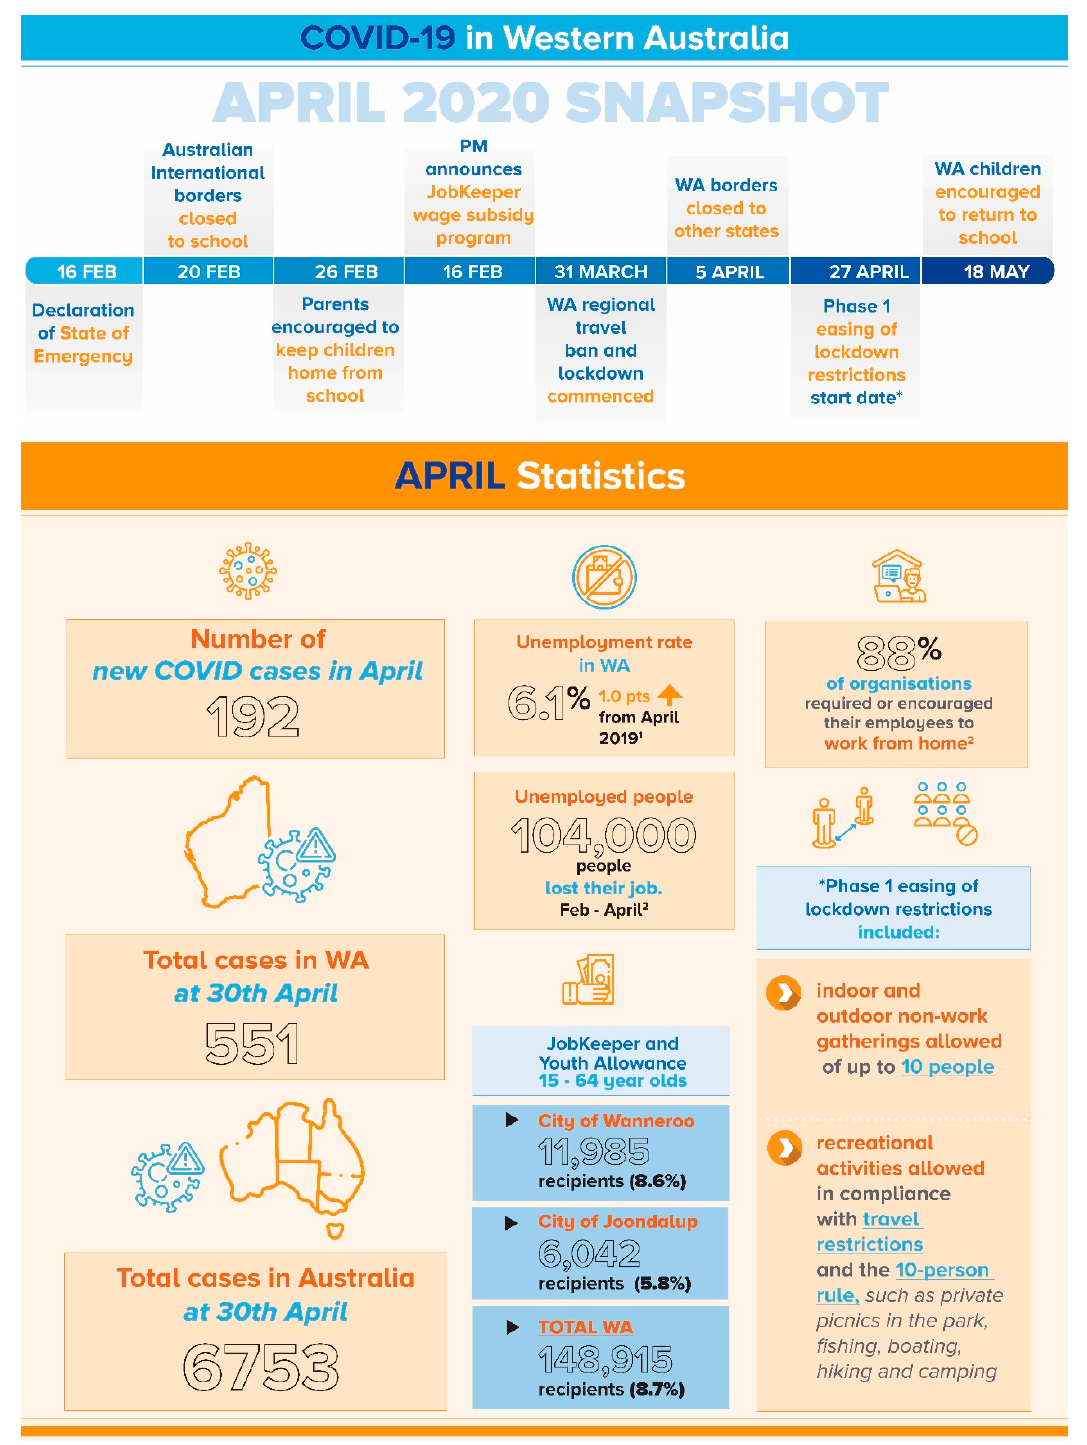
Figure 1. Timeline and Snapshot of COVID-19 events in Perth, Western Australia, as they affected the ORIGINS participants. Sources: 1 https://www.abs.gov.au/statistics/labour/employment-and-unemployment/labour-force-australia/apr-2020#covid-19-impacts-and-changes ; 2 https://www.cmo.com.au/article/672072/report-most-australian-employees-work-from-home/.